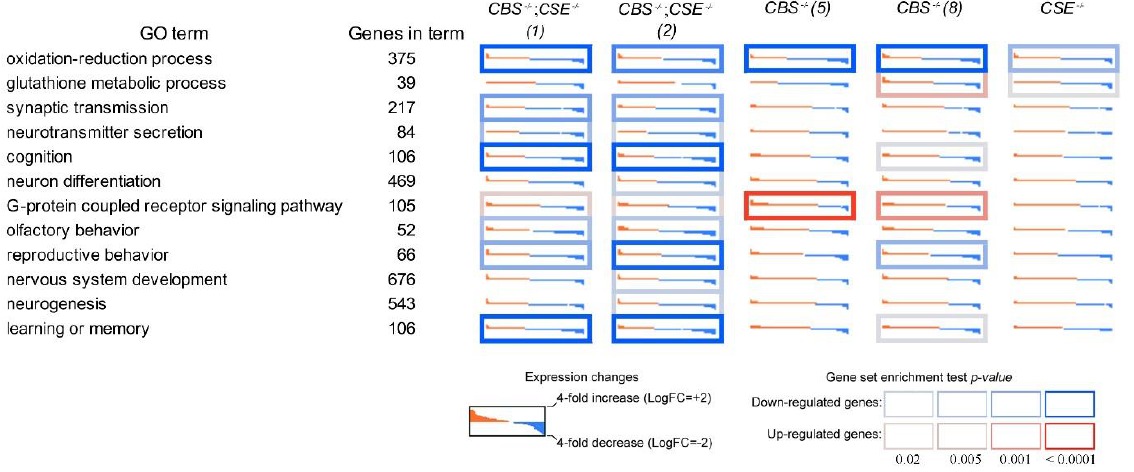
Figure 4. Gene ontology (GO) and pathway analysis of differentially expressed genes in the heads of naïve males. Expression level changes induced in the strains with single CBS-/- (5) and CBS-/- (8) , CSE-/- and double deletions CBS-/- ; CSE-/- (1), and CBS-/- ; CSE-/- (2) in the male heads. Each cell represents the sorted binary logarithms of expression value fold changes (LogFC) in the mutant strains versus control species for genes participating in a specific GO pathway. LogFC (vertical axis) ranges from -2 to +2, i.e., -2 from a 4-fold decrease (blue) to a 4-fold increase (red). Cell borders demonstrate the statistical significance of gene set enrichment analysis (Fisher test p -value): blue (enriched with downregulated genes) and red (enriched with overexpressed ones). (Color figure online). (For interpretation of the references to color in this figure legend, the reader is referred to the Web version of this article.).